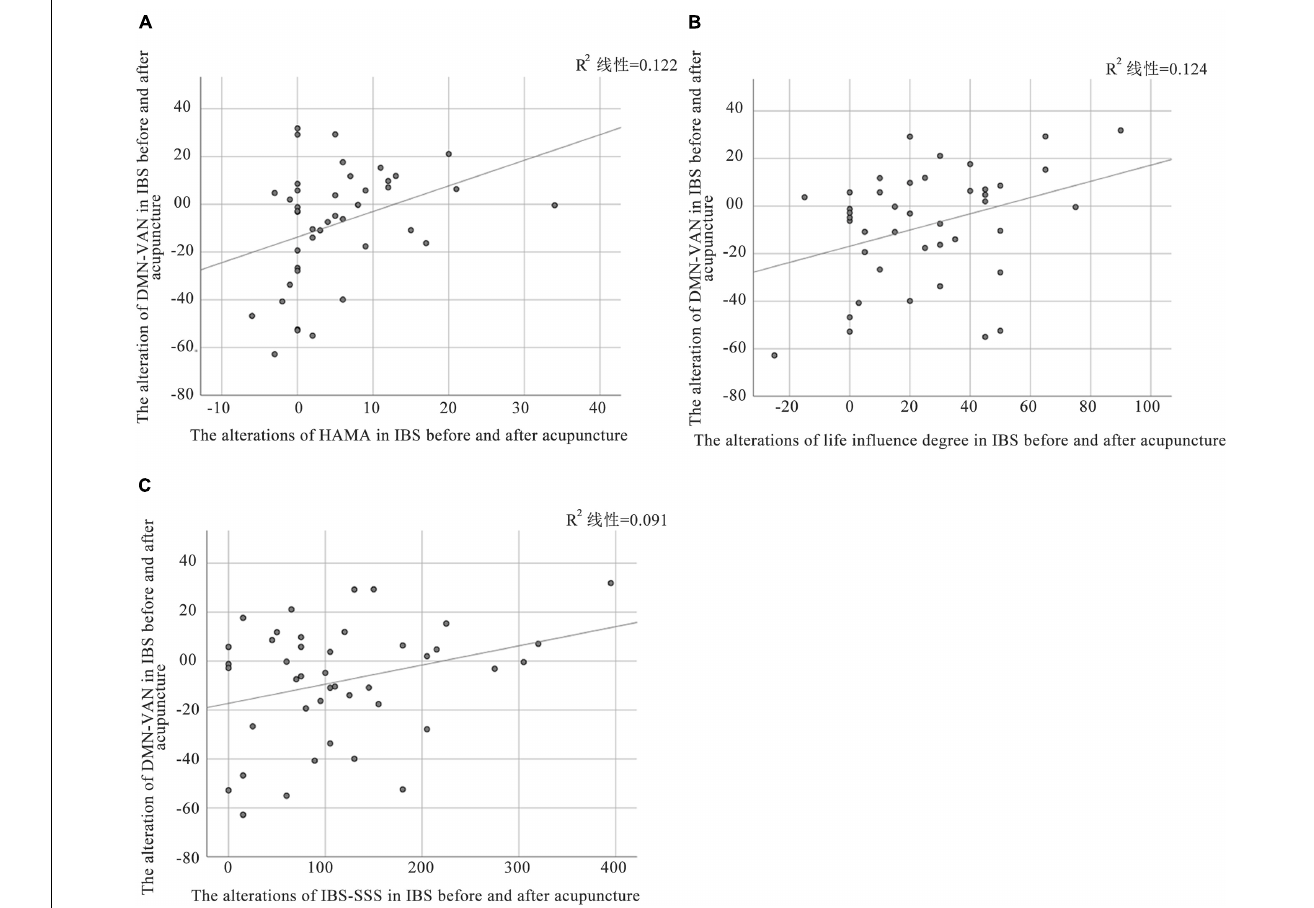
FIGURE 6 | Correlation between altered FC and clinical outcomes in patients with IBS. (A) The alteration of DMN-VAN was positively correlated with the changes in HAMA ( P = 0.024, r = 0.35); (B) The alteration of DMN-VAN was positively correlated with the changes in life influence degree ( P = 0.022, r = 0.32); (C) The alteration of DMN-VAN was were positively correlated with the changes in IBS-SSS ( P = 0.05, r =